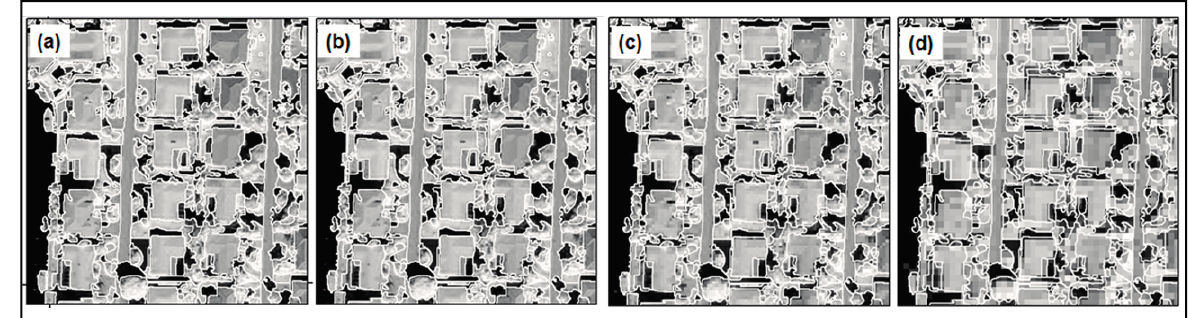
Figure 3. Reference image segments (white lines) overlaid onto the near infrared image of the study area at 0.3 m ( a ), 0.6 m ( b ), 1.5 m ( c ), and 3.0 m ( d ) spatial